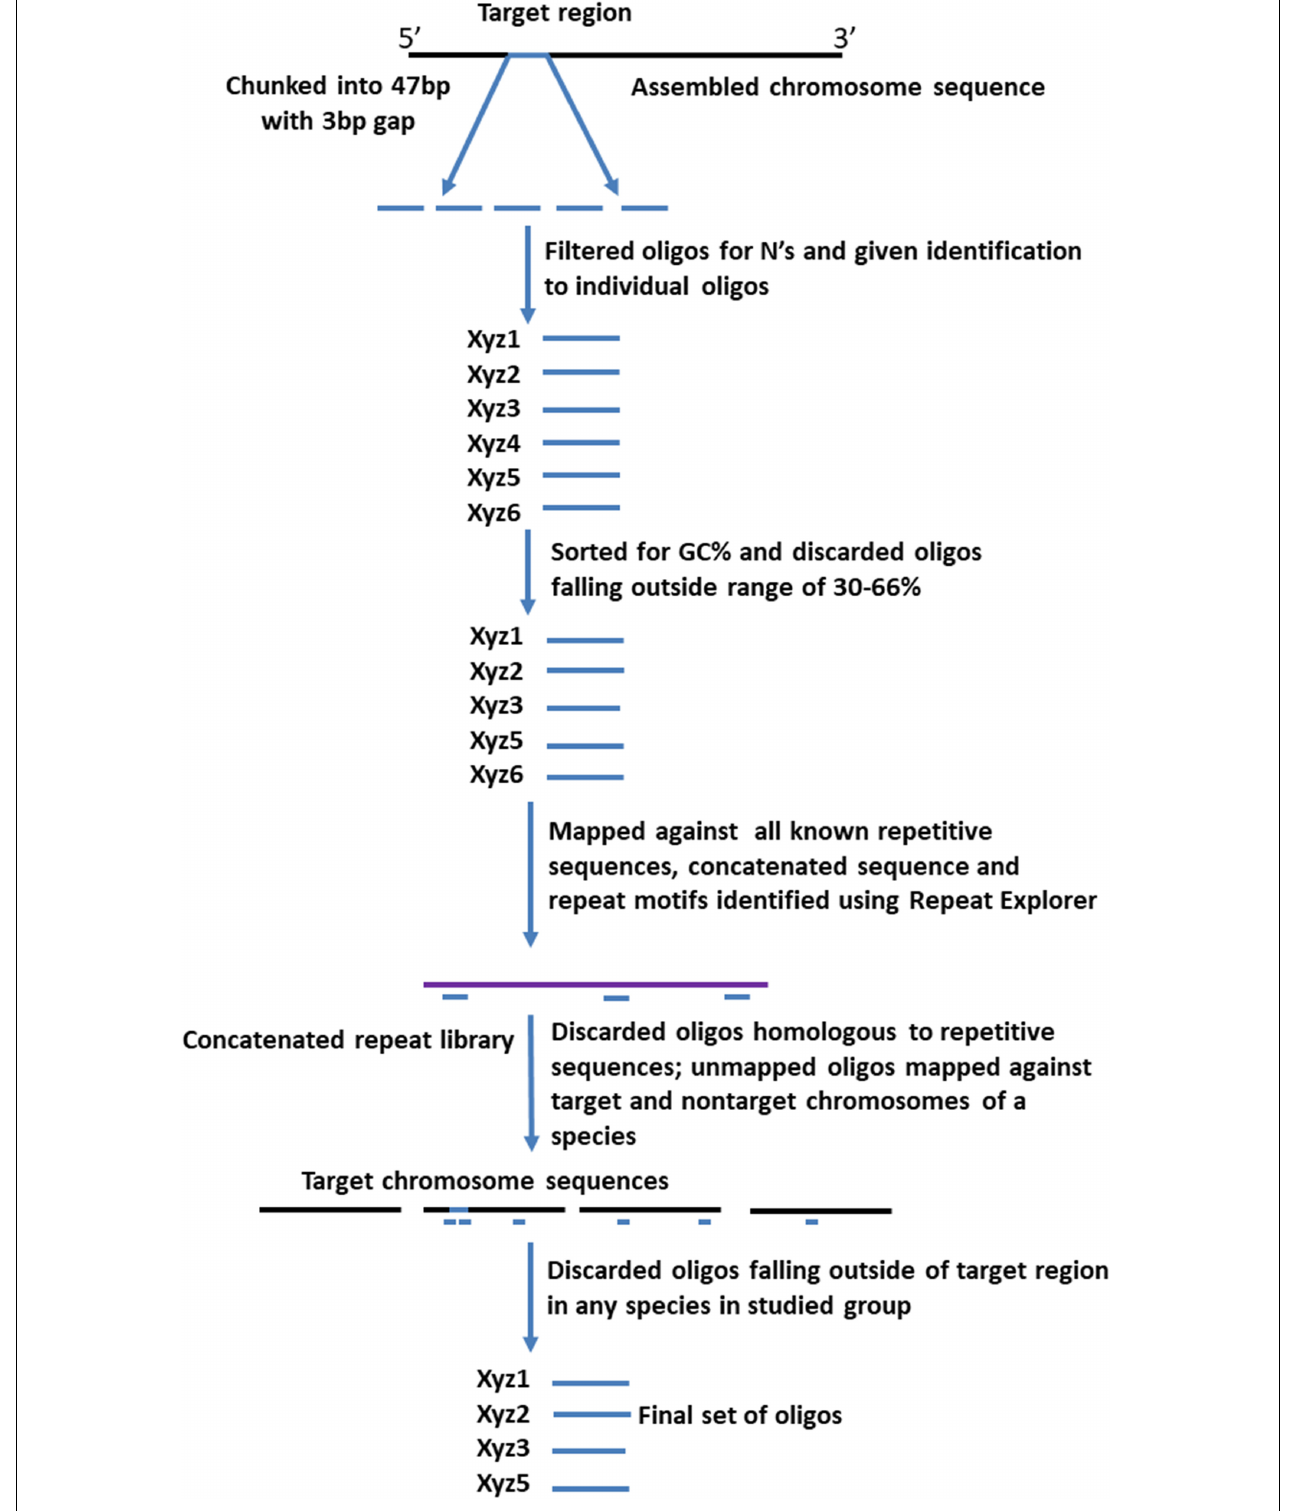
FIGURE 1 | Pipeline for designing of synthetic oligonucleotide libraries ( Table 1 ) to chromosome loci. After generating 47 bp oligonucleotides (“oligos”) from the target regions, those with ambiguities or extreme GC-content, or that hybridize (assessed by mapping in silico) to repetitive sequences and non-target chromosomes, are discarded. The final pool has oligonucleotides hybridizing specifically to the target chromosomal regions.